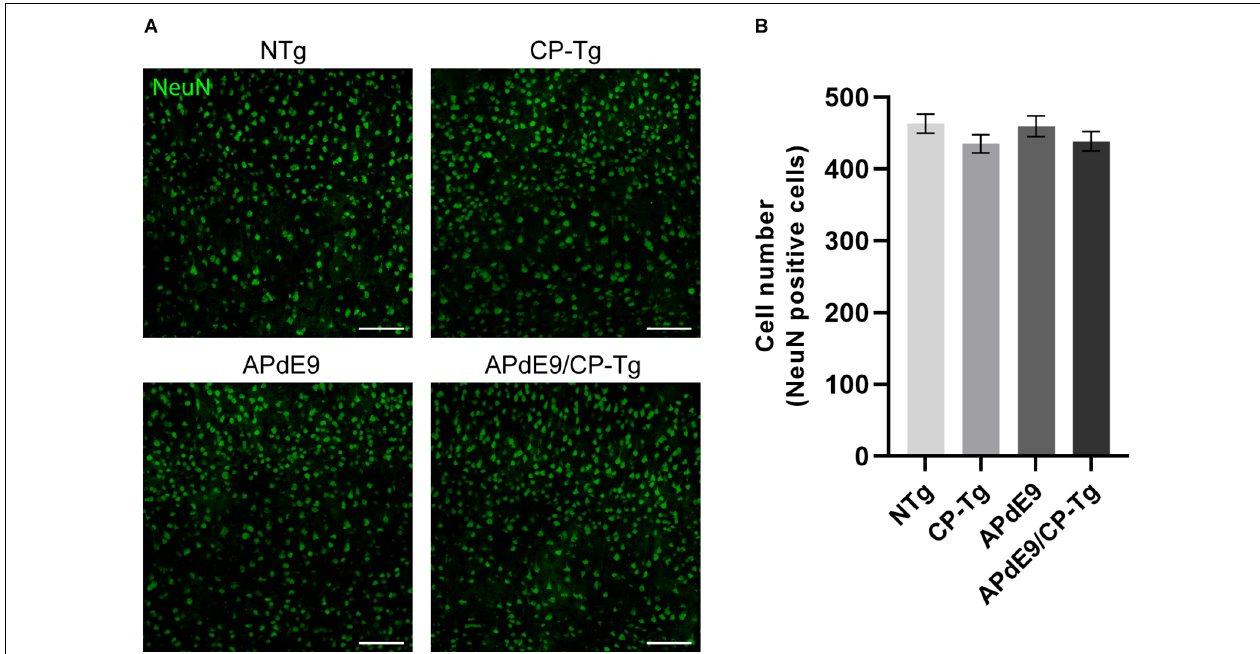
FIGURE 9 | No changes in neuronal loss were detected in cortices of the transgenic mice when compared to the control mice. Quantification of neurons, by NeuN staining, in the cortex of 17–20-month-old NTg, CP-Tg, APdE9, and APdE9/CP-Tg mice. (A) 20 × two-dimensional confocal images of NeuN-positive neurons were used for cell counting. Scale bar = 50 µ m. (B) APdE9 mice and both prostacyclin overexpression models showed no loss of cortical neurons. Bars are means ± SEM, n = 4–5 mice per